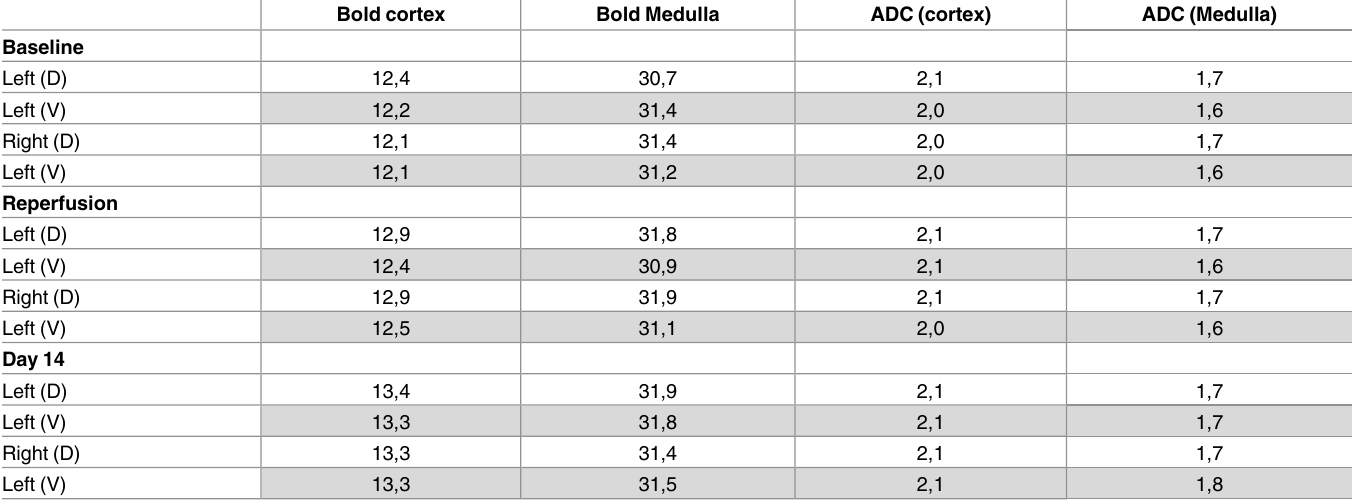
Table 1. Tissue metabolic activity (BOLD) and edema (ADC) measuredby MRI in the left and right kidneys from Danegaptide (D) and vehicle (V) treated animals on experimental Day 1 (baseline and after reperfusion) and Day 14, respectively. Bold cortex Bold Medulla ADC (cortex) ADC (Medulla)